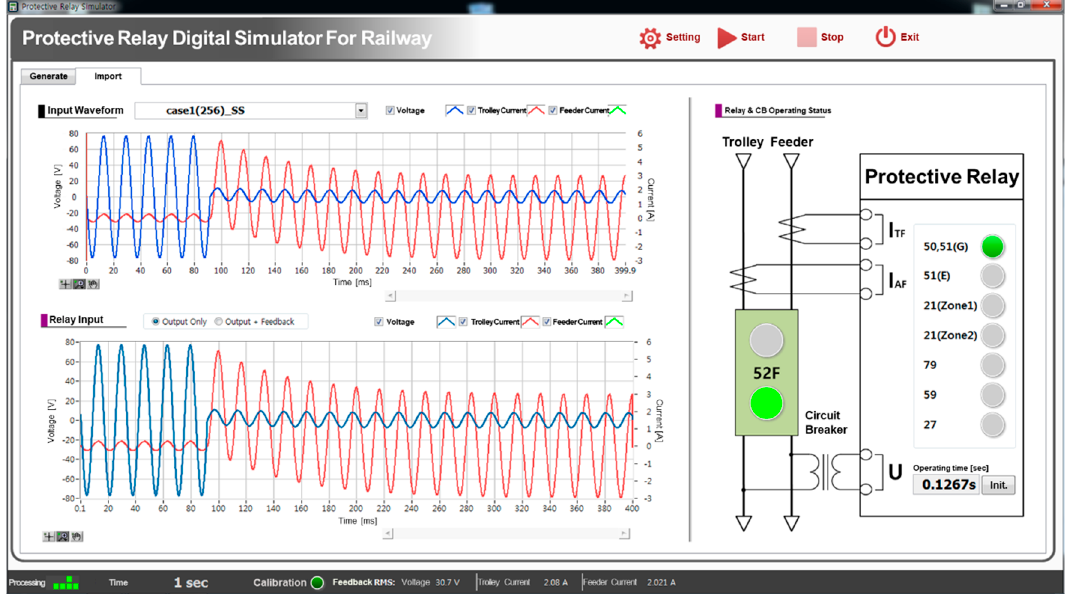
Figure 14. Simulation results for Case 1: ( a ) Input current; ( b ) Input voltage; and ( c ) Protective relay signal.